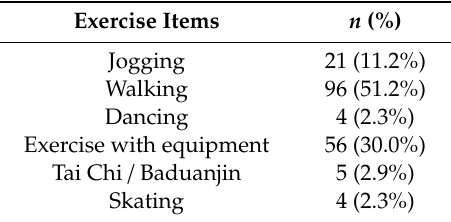
Table 2. Exercise items of the participants in the green spaces.